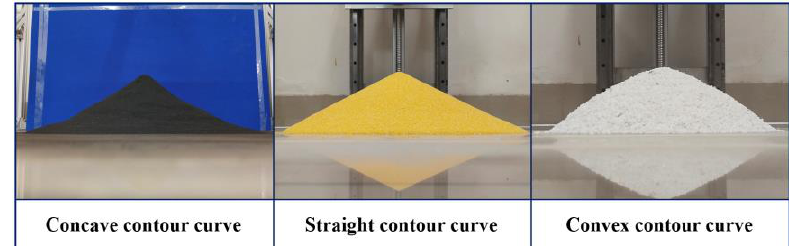
Figure 4. Schematic diagram of contour curve type of stockpile.